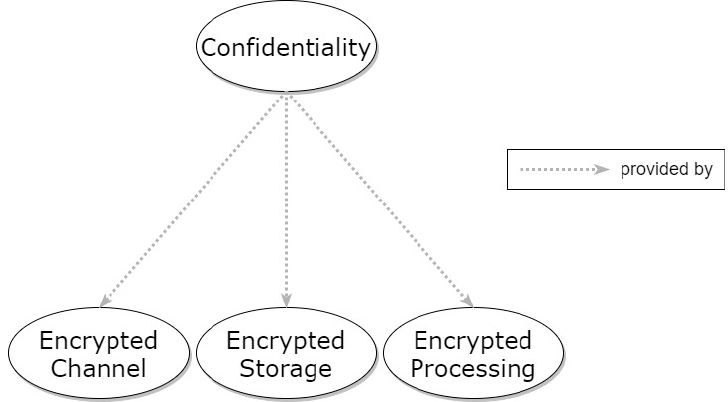
Figure 2. Hierarchical graph of Confidentiality property and relevant patterns.